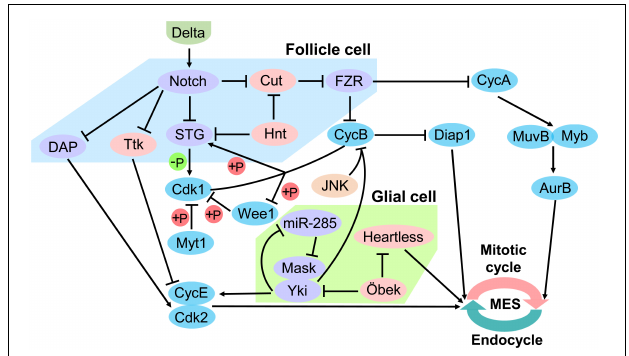
FIGURE 4 | Regulation of mitotic/endocycle switch. In the Drosophila follicle cell, Notch signaling pathway is a key upstream regulator of the mitotic/endocycle switch (MES). Activated Notch protein by the ligand Delta from oocytes terminates follicle cell proliferation and promotes MES by downregulating String (STG) and Dacapo (DAP) and upregulating FZR. In the Drosophila glial cell, Hippo signaling pathway is involved in MES. miR-285 suppresses Yki-Mask dimer activity by targeting Mask to downregulate cyclin E (CycE). Moreover, the N-terminal asparagine amidohydrolase homolog Öbek counteracts the activity of Yki and Heartless to limit endoreplication. FZR, Cdh1/Fizzy-related; Yki, Yorkie; Mask, Multiple Ankyrin repeats Single KH domain; Hnt, Hindsight; Ttk, Tramtrack; Cdk1 and 2, Cyclin-dependent kinase 1 and 2; Myt1, Myelin transcription factor 1; CycA and B, cyclin A and B; Diap1, Drosophila inhibitor-of-apoptosis protein 1; AurB,